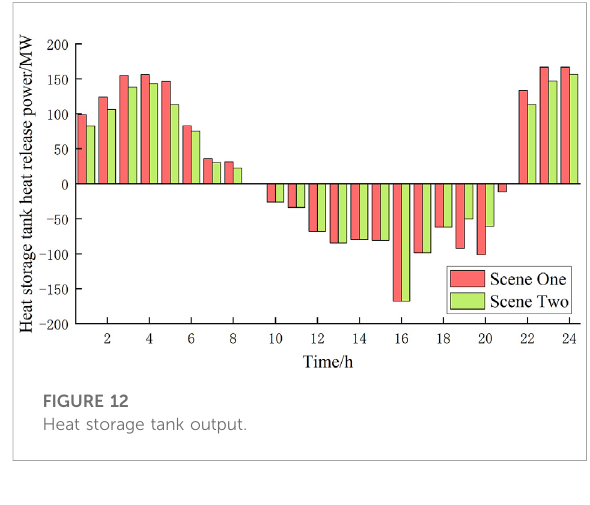
FIGURE 12 Heat storage tank output.